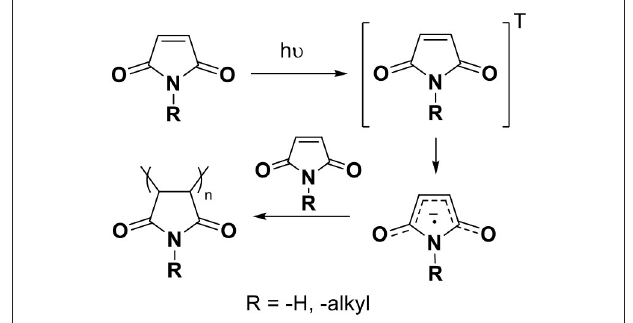
FIGURE 2 | Homopolymerization of monomaleimides by radical mechanism.